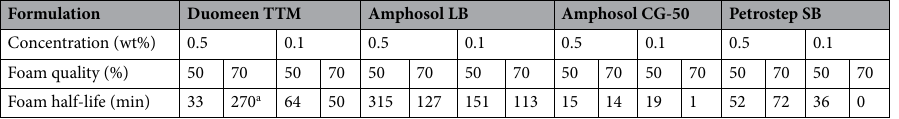
Table 2. Sc-CO 2 foam half-life determined at 0.1 and 0.5 wt% surfactant concentrations in Brine 1 and at two distinct foam qualities of 50% and 70%. a Lower limit to actual half-life calculated from fit of period of highest rate of lamella decrease, which oscillated at 178 ± 35 (mean ± sd) overall.